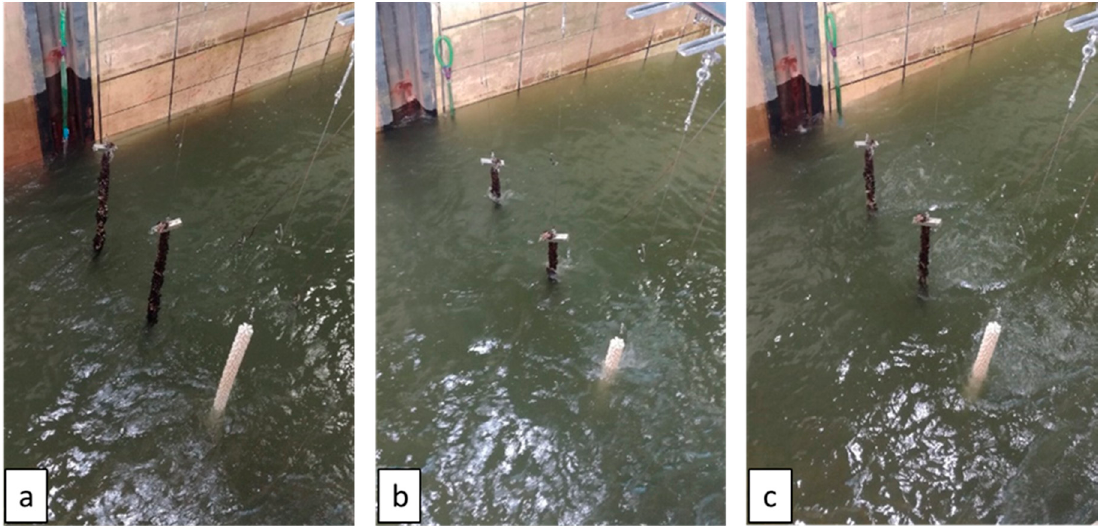
Figure 4. Exposure of dropper lines in waves. ( a ) Forward motion in wave trough. ( b ) Backward motion in wave crest. ( c ) Wake formation behind lines at approximately zero crossing.